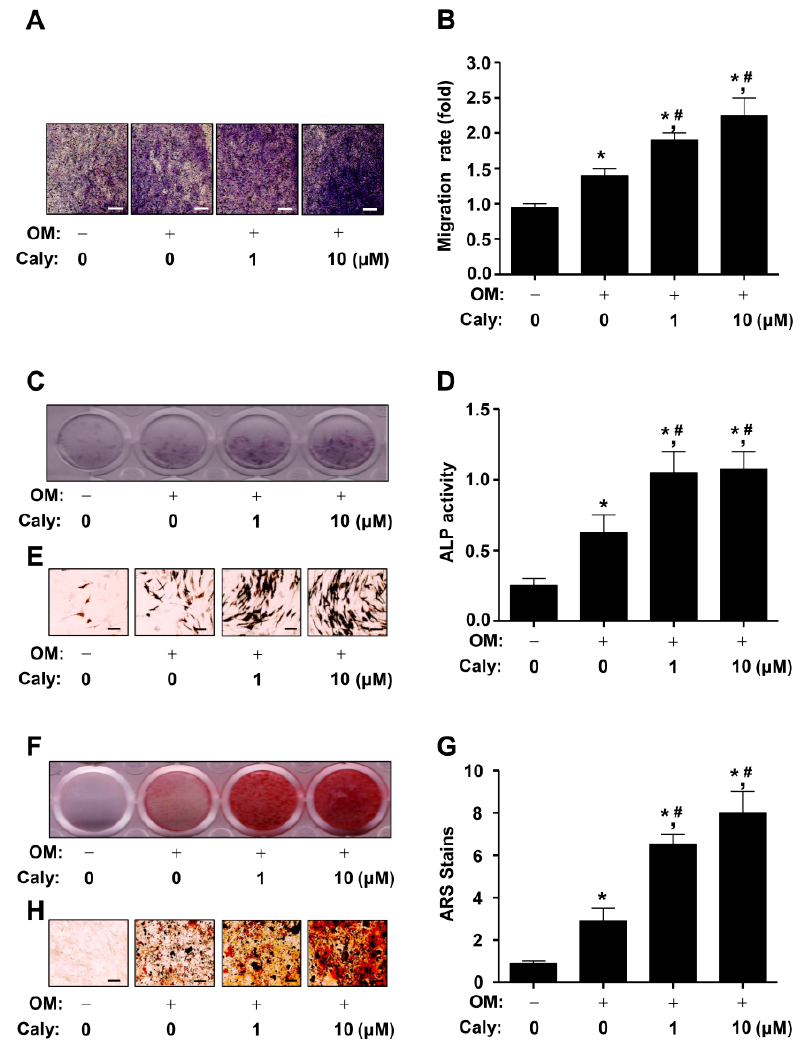
Figure 2. Effects of Caly on the osteogenesis of human MSCs. ( A ) Cell migration was measured by the Boyden chamber assay. The migrated cells were stained with 0.1% crystal violet and visualized under a light microscope. Scale bar: 50 µ M. ( B ) The bar graph shows cell migration rate (fold) normalized to the control. ( C – E ) Early osteogenesis was measured by the ALP staining and activity assay at 7 days. The early osteogenic cells were stained with ALP reaction solution. The staining was visualized under a scanner ( C ). ALP activity was quantitatively measured using a spectrophotometer ( D ). ALP-positive expressing cells were visualized under a light microscope ( E ). Scale bar: 50 µ M. ( F – H ) Late osteogenesis was measured by ARS staining assay at 21 days. After staining with 2% ARS solution, the mineralization was visualized under a scanner ( F ), quantitatively analyzed using a spectrophotometer ( G ), and visualized under a light microscope ( H ). Scale bar: 100 µ m. Data are expressed as the mean ± S.E.M. from three separate experiments (* p < 0.05 compared to the control, and # p < 0.05 compared to